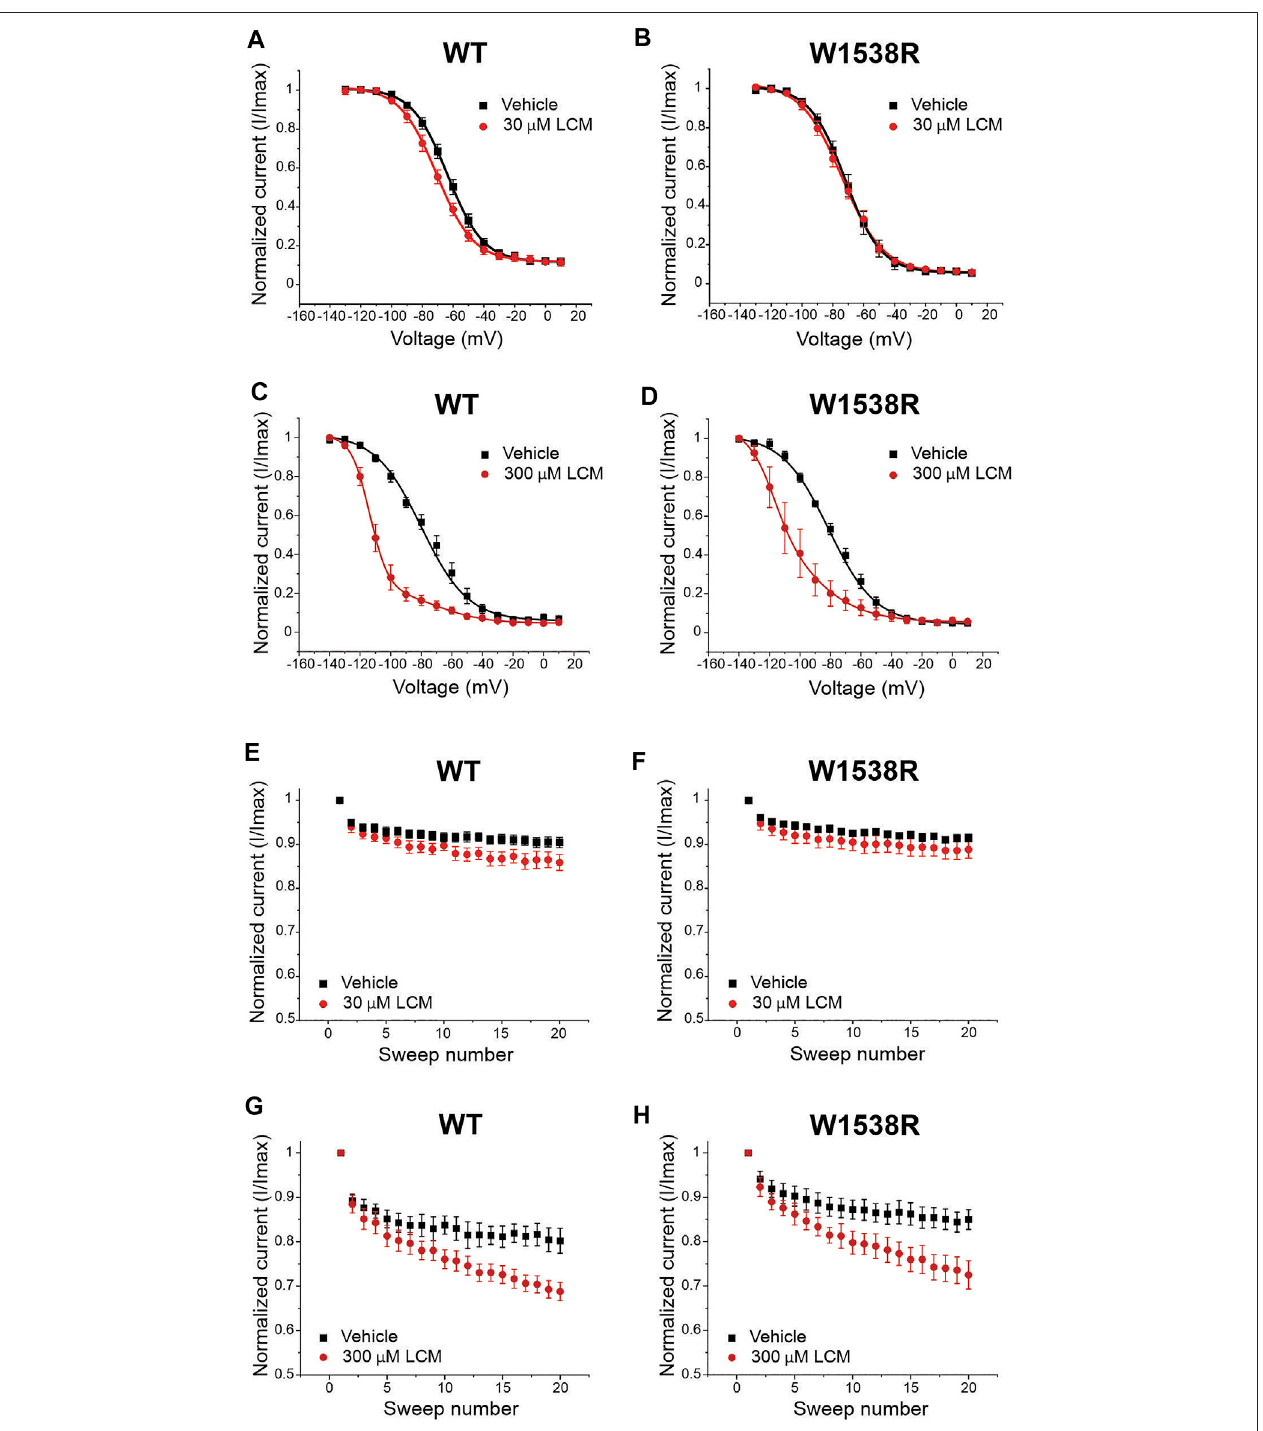
FIGURE 4 | Na V 1.7-W1538R channels are inhibited after a 10-fold increase in the lacosamide therapeutic concentration. The effect of lacosamide on Na V 1.7 voltage-gating properties were evaluated for (A – D) Voltage-dependence of slow inactivation and (E – H) use-dependence of inhibition at 20 Hz. The slow inactivation curves were fi tted to a single Boltzmann for vehicle and 30 μ M lacosamide, and to a double Boltzmann equation for 300 μ M lacosamide. Cells expressing Na V 1.7-WT or Na V 1.7-W1538R were either treated with lacosamide at the clinically-achievable dose of 30 μ M (shown in red, A,B,E,G ), its 10-fold increase of 300 μ M (shown in dark red, C,D,F,H) , or vehicle (black; extracellular bath solution).